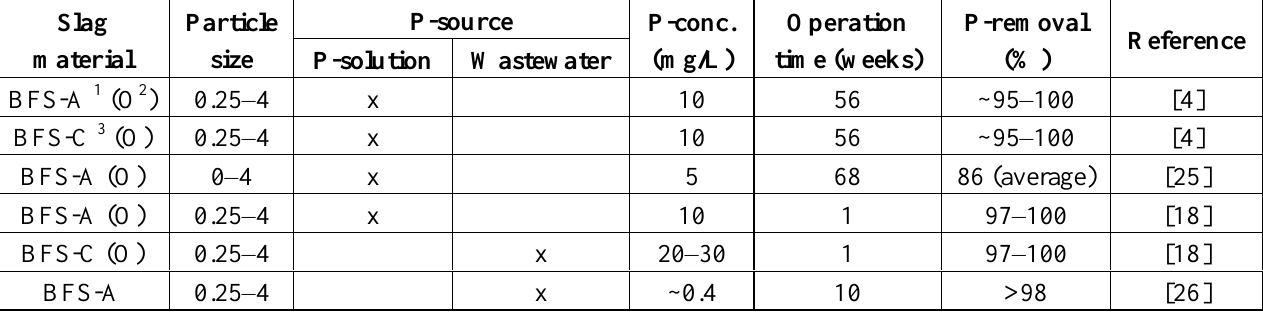
Table 3. P removal in longer term column studies fed by laboratory made solution and real